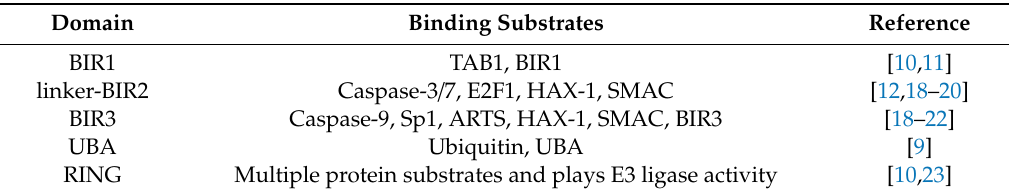
Table 1. The binding substrates of each domain in XIAP.